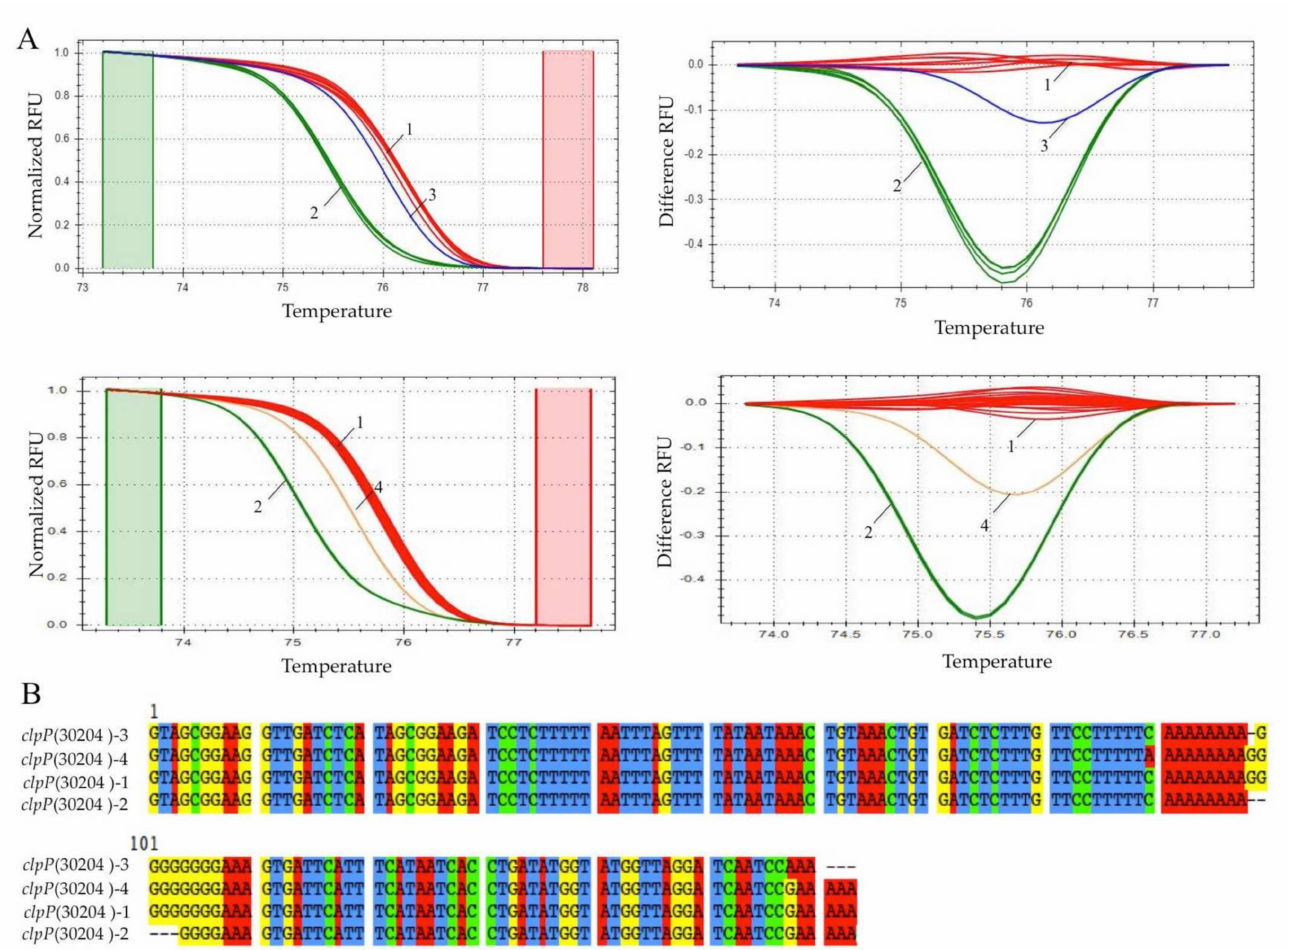
Figure 2. Real-time PCR-HRM analysis with primer set clpP (30204). ( A ) Representative normalized (left) and difference curves (right) depicting different alleles: clpP (30204)-1 (red), clpP (30204)-2 (green), clpP (30204)-3 (blue) and clpP (30204)-4 (yellow). ( B ) Sequence alignment comparing the amplicons of the different alleles including